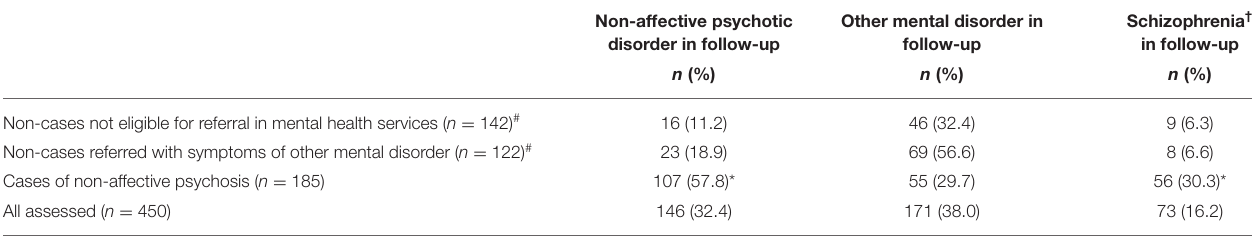
TABLE 2 | Mental disorders during follow-up.